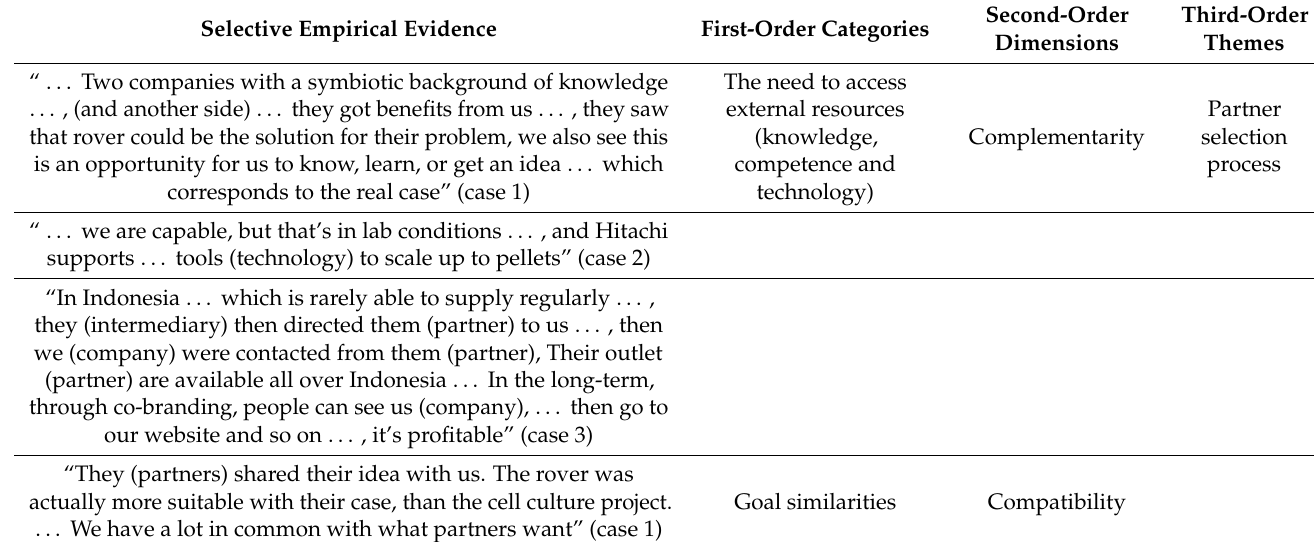
Table 2. Example of exploring the bottom-up emergence of partner selection